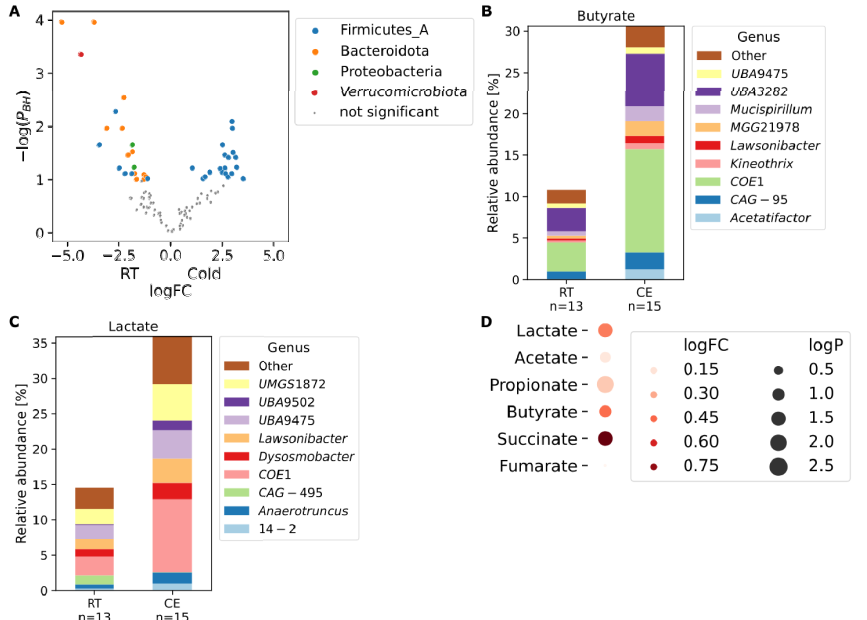
Fig 3. CMMG links functional changes to driver species. | (A) Volcano plot of species changes in mouse cecal microbiota upon cold exposure. Significantly changed species are colored by their phylum. P BH : P-value corrected for multiple testing using the Benjamini-Hochberg procedure. (B, C), Bar plots of butyrate (B) and lactate (C) in mouse cecal microbiota upon cold exposure. Contribution to the relative abundance of each module is partitioned by genus. (D) Dot-plot of metabolite changes in ceca from germ-free mice transplanted with cold-adapted microbiota compared to RT-microbiota transplanted controls. Source: [26]. CE: Cold exposure, RT: Room temperature control.